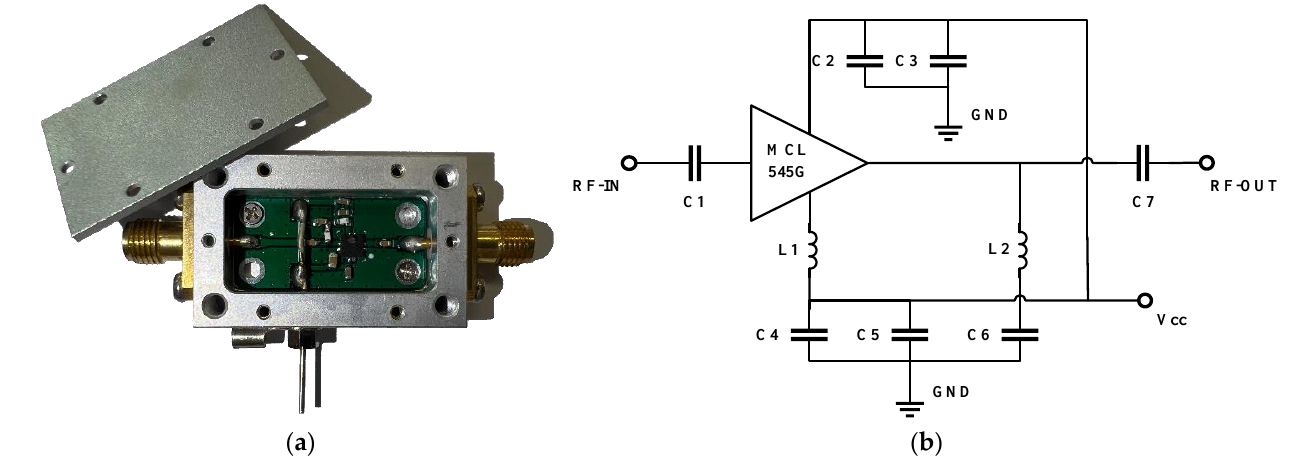
Figure 13. LNA sample: ( a ) photo; ( b ) circuit schematic.